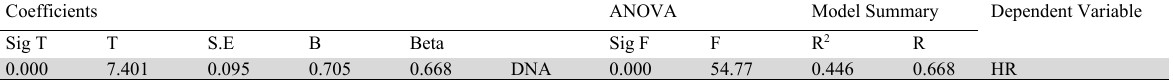
The results of the simple regression analysis for exploring the impact of the organizational DNA doesn’t on human resources in commercial banks in Madaba